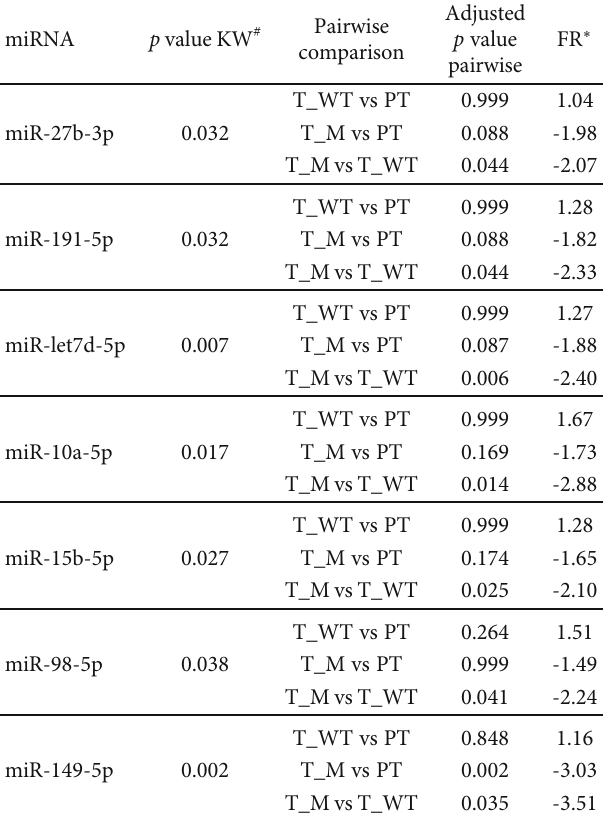
Table 3: The table shows the miRNAs di ff erentially expressed among the three groups. In blue font, it is reported that the FR of the miRNAs downregulated in tumoral tissues with KRAS mutations vs tumoral KRAS wild